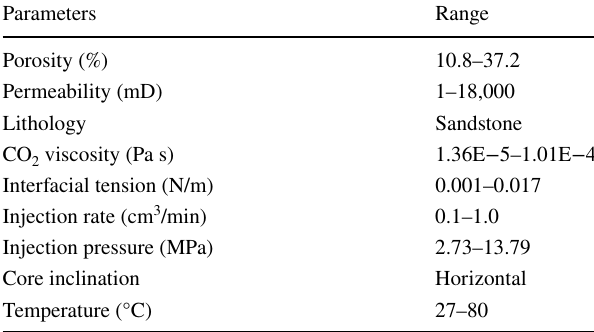
Table 1 Range of used parameters